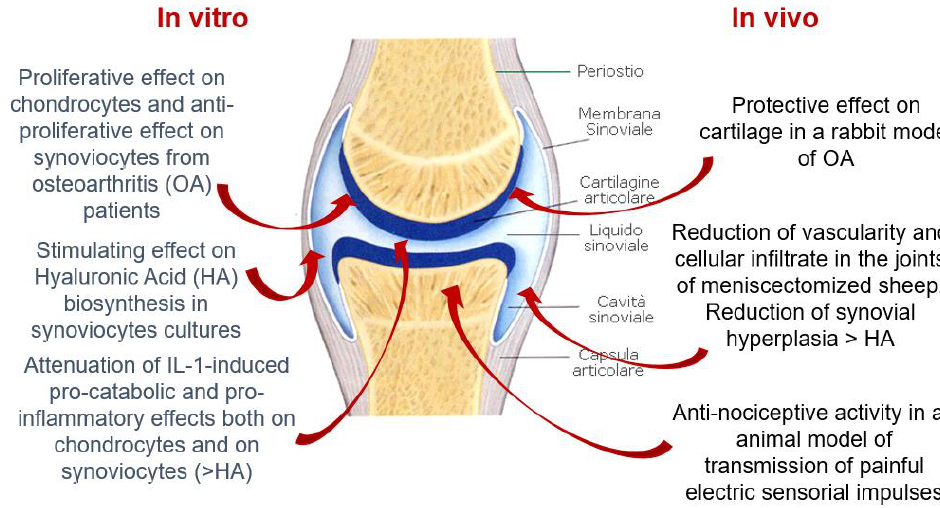
Figure 2. Hymovis. In vitro and in vivo properties.